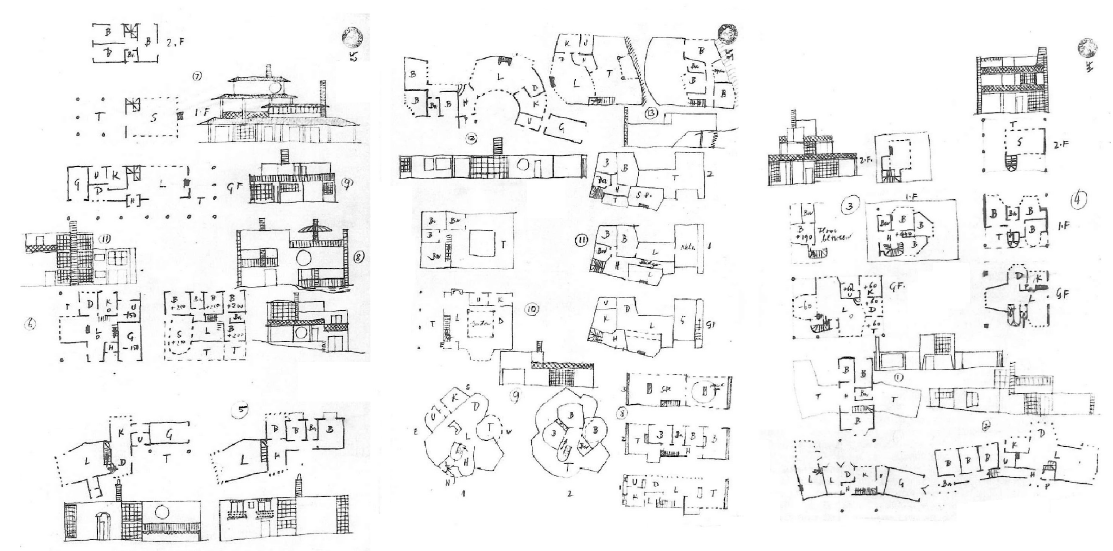
Figure 1. The three houses collected on 3 sheets of transparent paper.